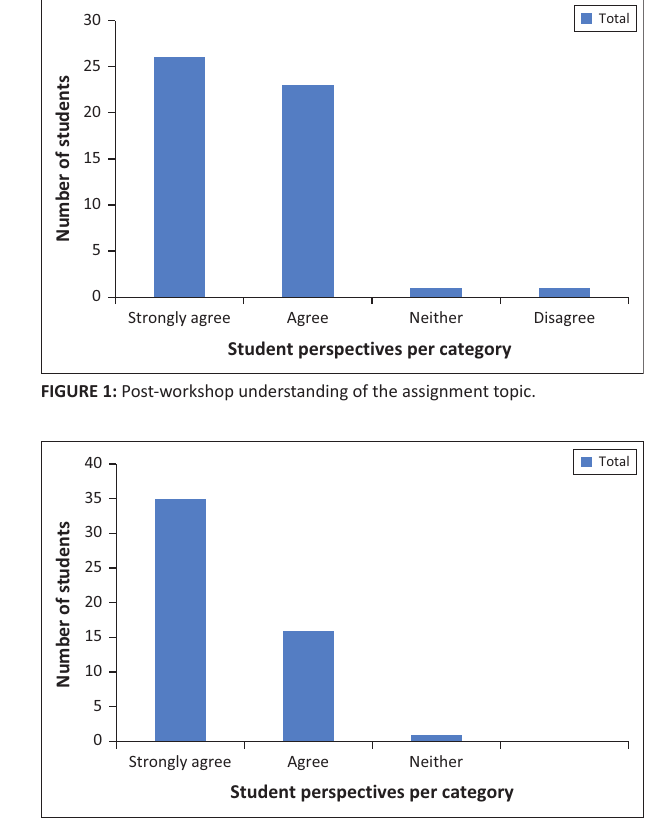
FIGURE 2: Post-workshop understanding of the required assignment structure.